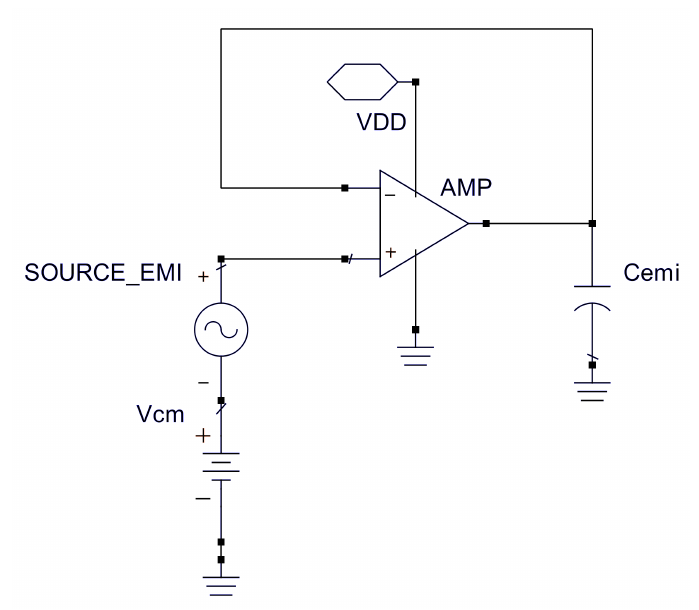
Figure 2. Simulations of the EMI effect: EMI directly injected into the non-inverting pin.